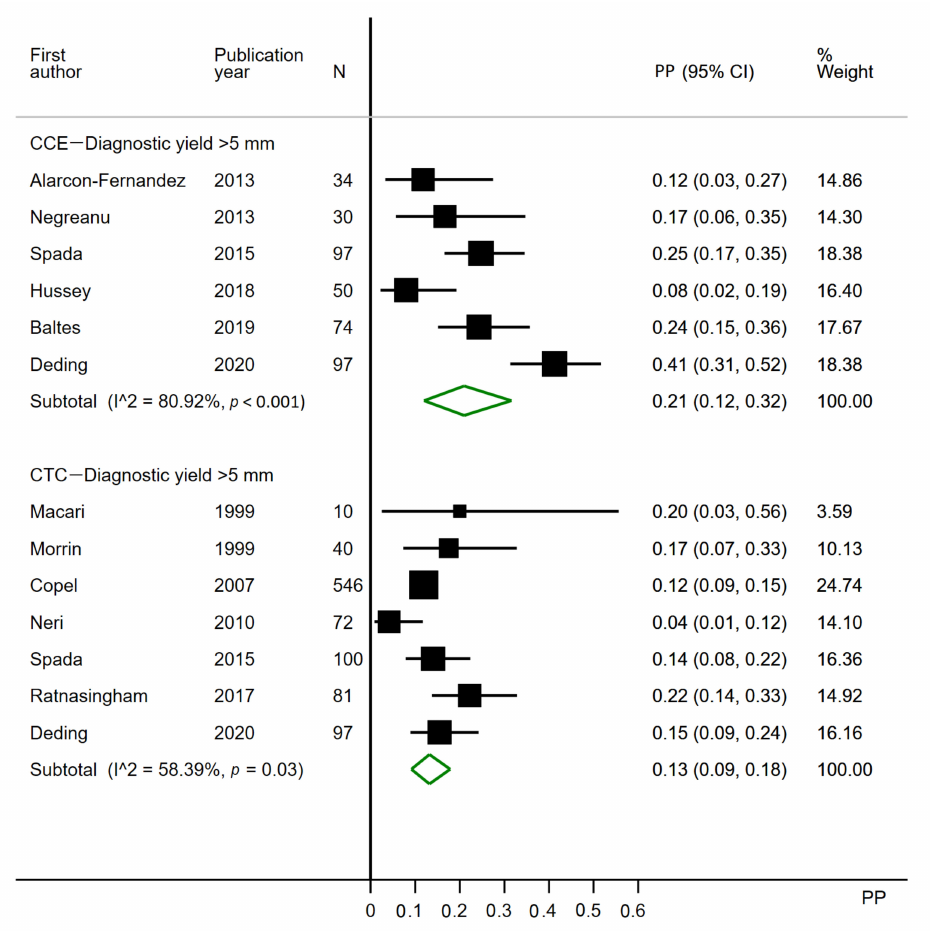
Figure 4. Forest plot of per patient diagnostic yields for polyps > 5 mm in colon capsule endoscopy and in CT colonography following incomplete colonoscopy. PP: estimated prevalence